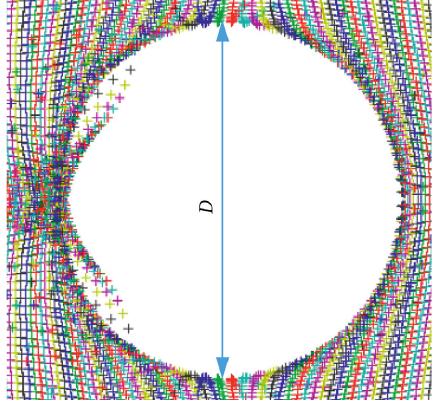
Figure 2: The morphology of mode I